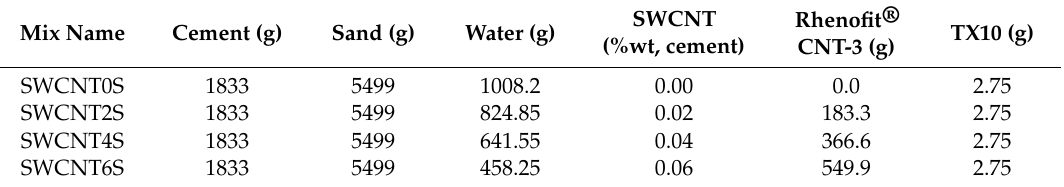
Table 8. Mix design of SWCNT-added mortars with treatment of TX10.